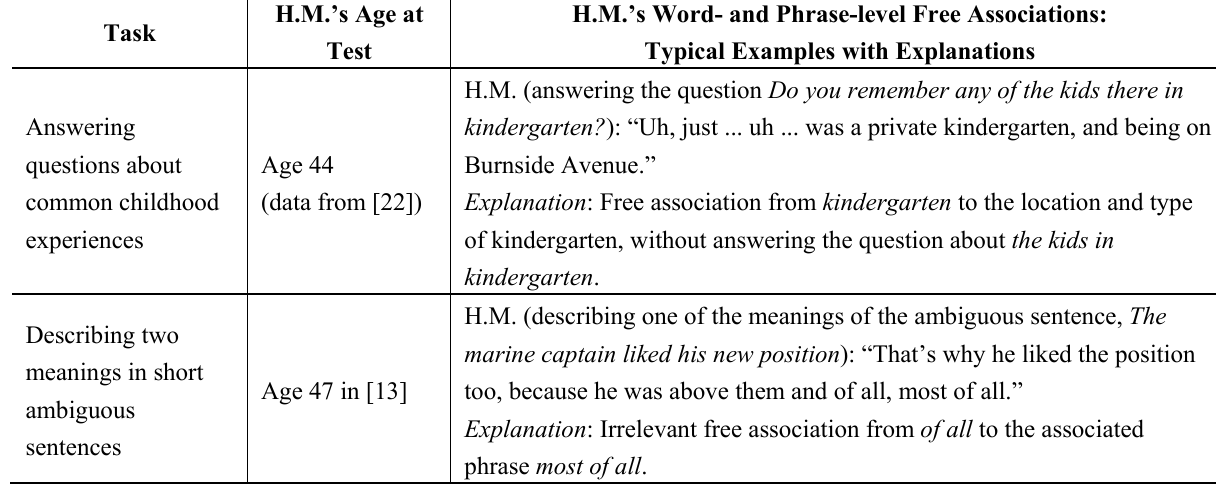
Table 2. H.M.’s word- and phrase-level free associations in five earlier tasks with explanations, typical examples, and age at